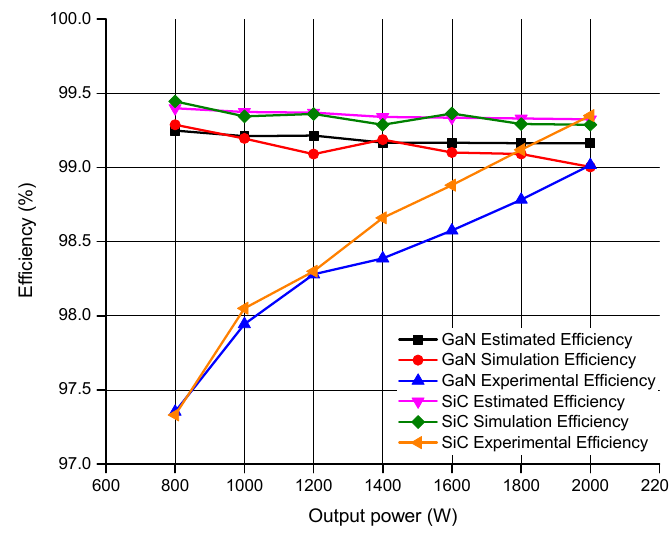
Figure 11. Efficiency according to the output power. Figure 11. E ffi ciency according to the output